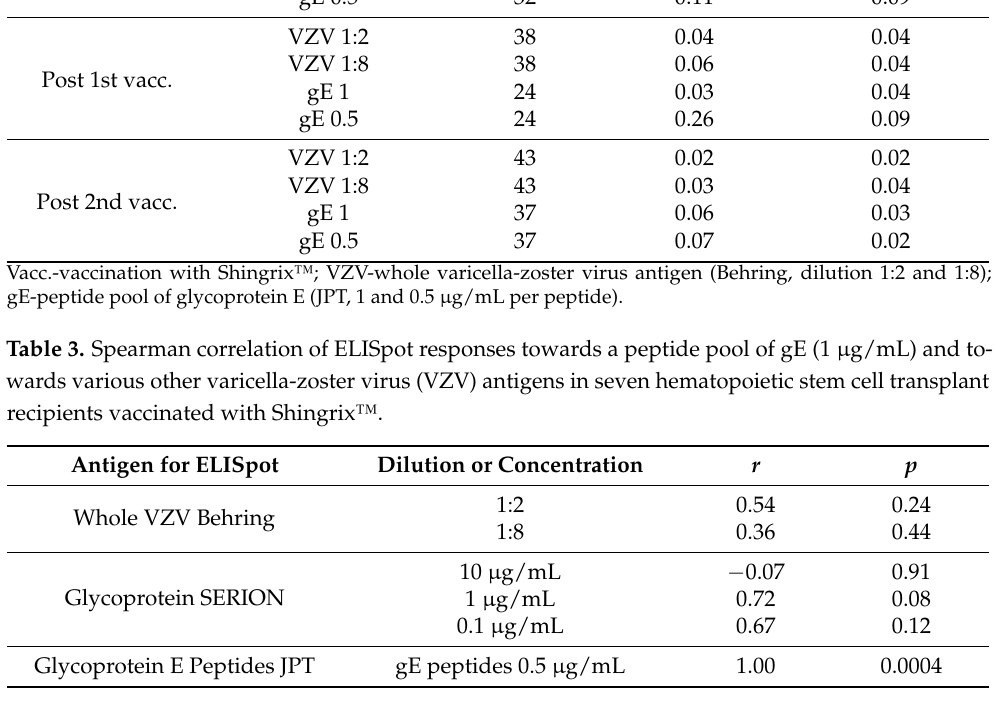
Table 4. Spearman correlation of ELISpot responses towards a whole varicella-zoster virus (VZV) antigen and a peptide pool of glycoprotein E in hematopoietic stem cell transplant recipients prior to and post vaccination with